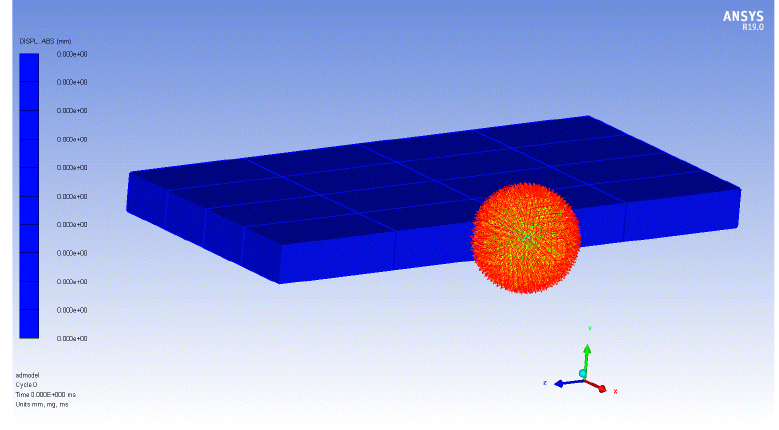
Figure 4. Side explosive charge.